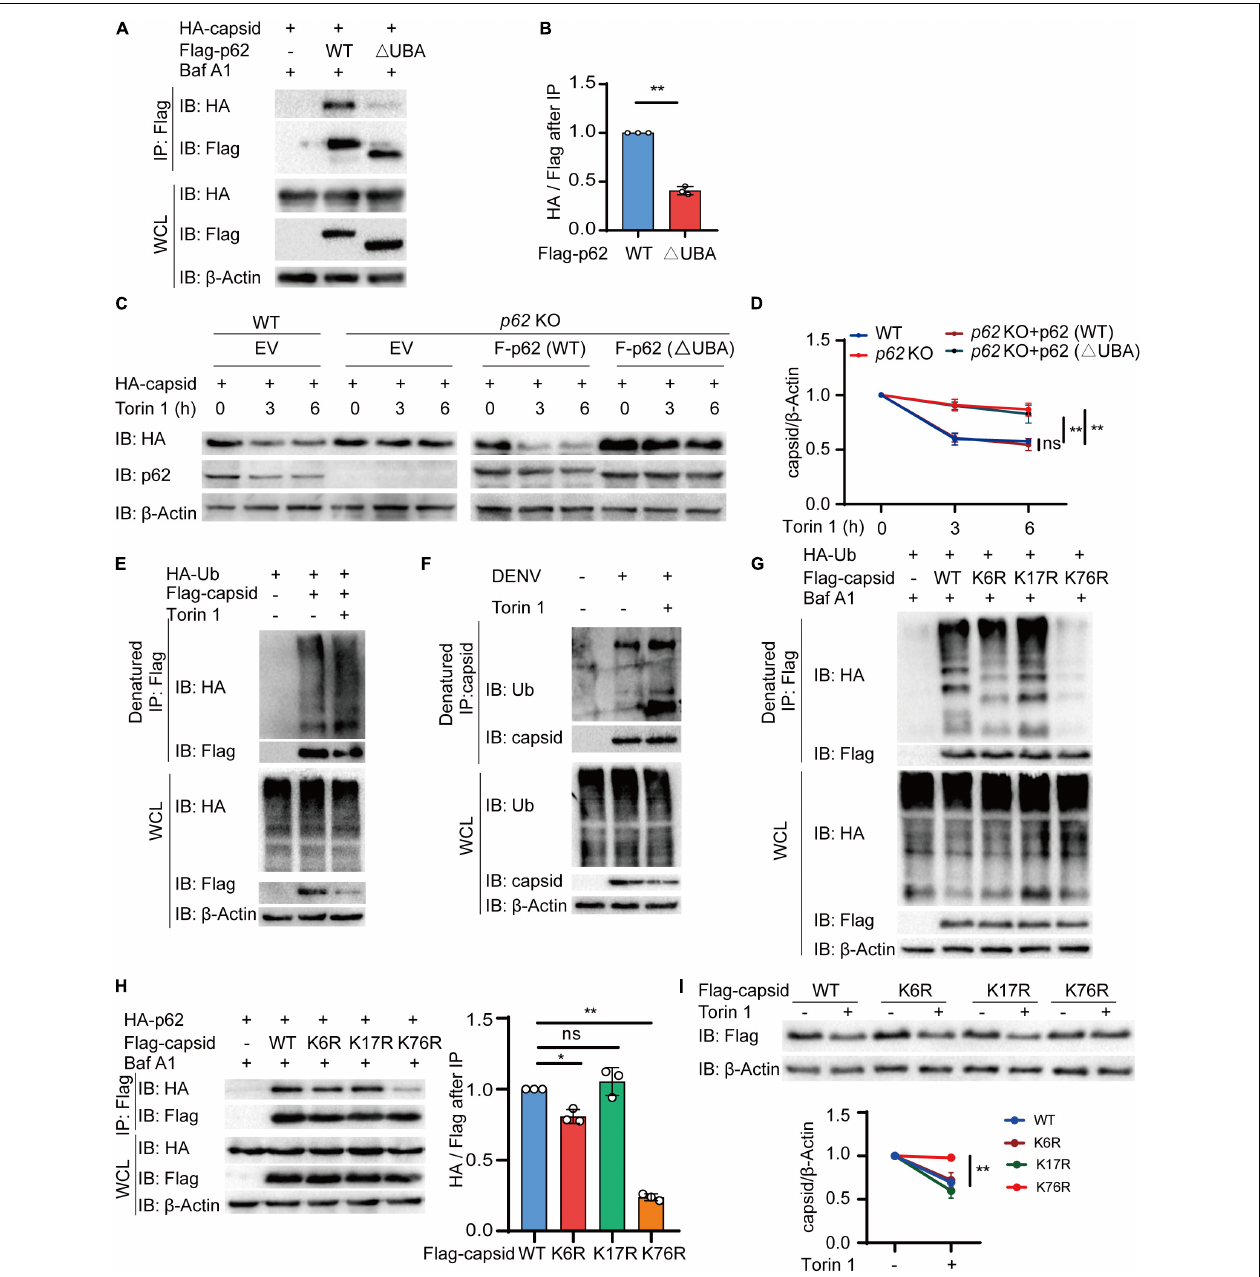
FIGURE 5 | p62 recognizes dengue virus (DENV) capsid protein through its ubiquitination at lysine 76. (A) Coimmunoprecipitation and immunoblot analysis of 293T cells transfected with plasmids expressing HA-p62 and Flag-C protein and its (cid:77) UBA mutant with 0.2 µ M Baf A1 treatments for 6 h. (B) The ratios between HA and Flag after immunoprecipitation from (A) were analyzed. (C) Flag-p62 protein or its (cid:77) UBA mutant was transfected into WT or p62 KO 293T cells, followed by HA-C transfection for 24 h and 2 µ M Torin 1 treatments for indicated time points before harvesting. The cell lysates were immunoblotted with indicated antibodies. (D) The quantified levels of C protein from (C) were normalized to β -actin. (E) Denatured immunoprecipitation and immunoblot analysis of 293T cells transfected with plasmids expressing Flag-C protein and HA-ubiquitin with or without 2 µ M Torin 1 treatments for 6 h. (F) Denatured immunoprecipitation and immunoblot analysis of Huh7 cells infected with DENV (MOI = 0.5) for 48 h, followed with or without 2 µ M Torin 1 treatments for 6 h. (G) Denatured immunoprecipitation and immunoblot analysis of 293T cells transfected with plasmids expressing Flag-C protein (WT, K6R, K17R, or K76R) and HA-ubiquitin with 0.2 µ M Baf A1 treatments for 6 h. (H) Coimmunoprecipitation and immunoblot analysis of 293T cells transfected with plasmids expressing Flag-C protein (WT, K6R, K17R, or K76R) and HA-p62 with 0.2 µ M Baf A1 treatments for 6 h. (I) Flag-C protein or its mutants (K6R, K17R, or K76R) were transfected into 293T cells, followed by 2 µ M Torin 1 treatments for 6 h. The cell lysates were immunoblotted with indicated antibodies and quantified levels of C protein were normalized to β -actin. Data in (B,D,H,I) are expressed as mean ± SEM of three independent experiments. * p < 0.05, ** p < 0.01, ns, not significant (two-tailed Student’s t -test). All the experiments are representatives of three independent biological experiments with similar